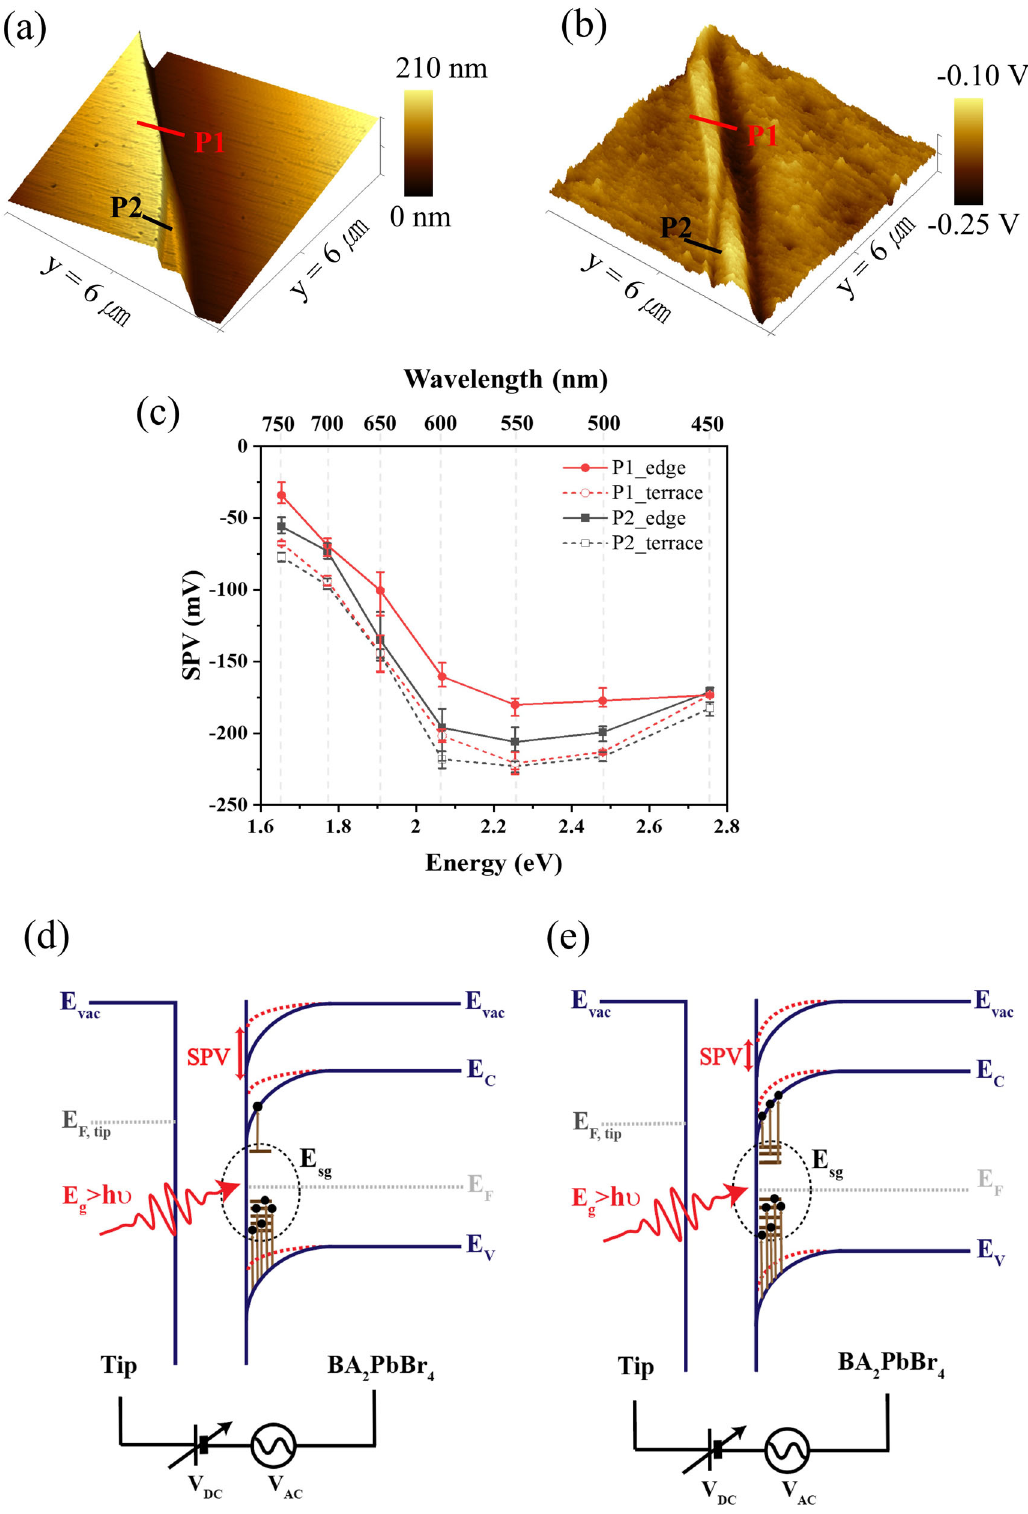
Fig. 3 Surface photovoltage of two edge regions as a function of illumination wavelength. a Topography and b the corresponding SPV image (subtracted CPD images acquired in the dark from that of under 450 nm illumination). c SPV signal change as a function of incident photon energy for two different regions of edges and terraces marked with the red and black lines in panel a and b denoted by P1 and P2, respectively. Energy band diagram change under sub-bandgap illumination in case of d low edge height (e.g., P2) and e high edge height (e.g., P1). E tip : work function of the tip; E sg : energy level of sub-bandgap